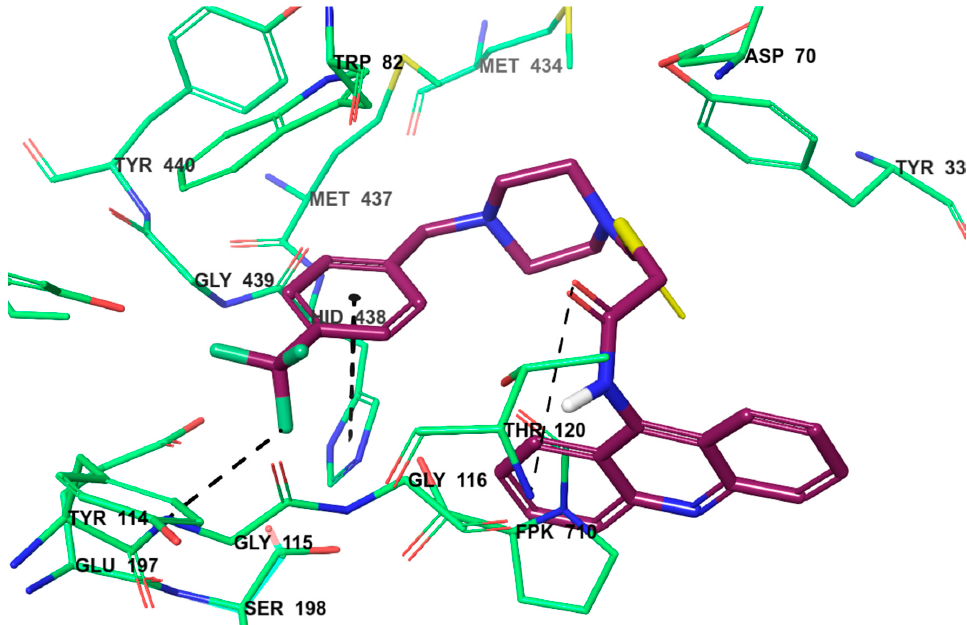
Figure 5. Three-dimensional interaction of compound 4n with BChE.